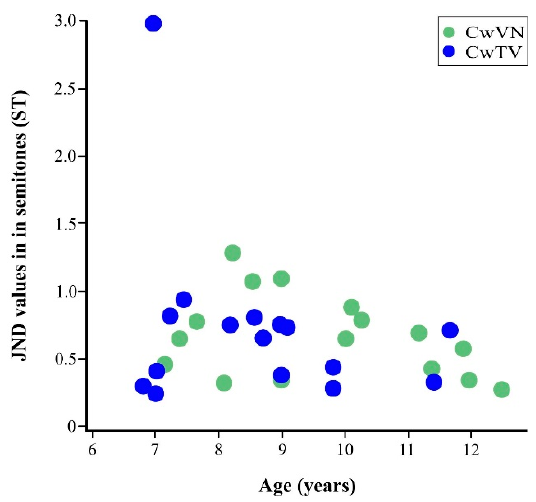
Figure 2. Just-noticeable-difference (JND) values in semitones (ST) for the children with vocal fold nodules (CwVN, green circles) and the age-matched children with typical voices (CwTV, blue circles).